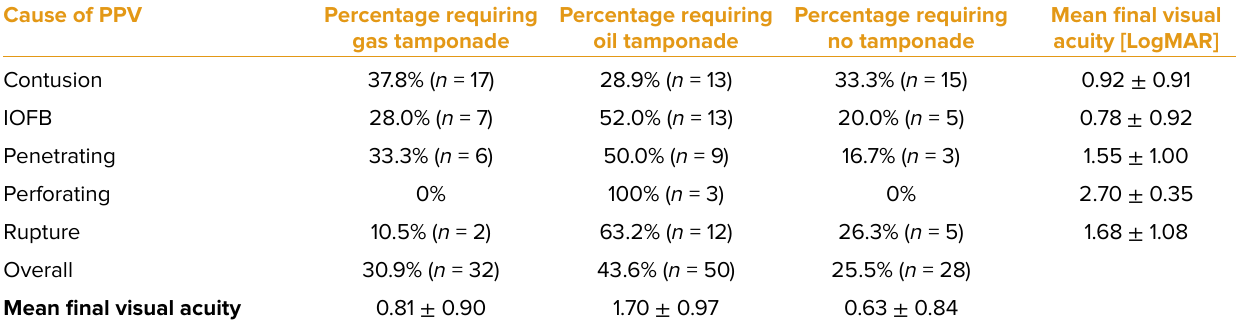
Table 3. Frequency of different types of tamponade use in BETTS groups with overall final visual acuity[LogMAR] Cause of PPV Percentage requiring Percentage gas tamponade